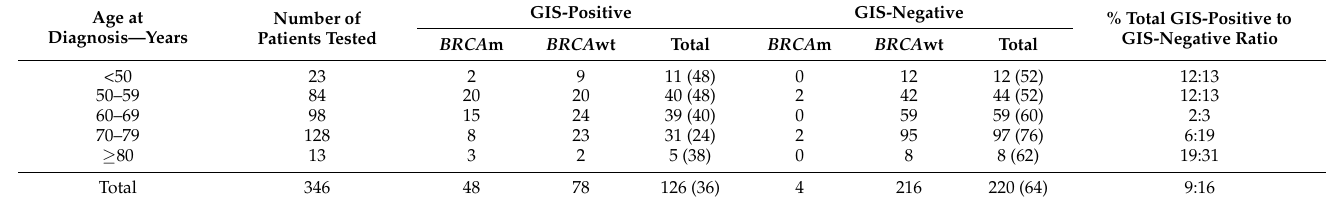
Table 4. Genomic instability score status categorized by age group. Data are presented as number (percentage; the denominator is the ‘Number of patients tested’ in each age group). Key: BRCA m, BRCA1/2 pathogenic variant; BRCA wt, BRCA1/2 wild type.